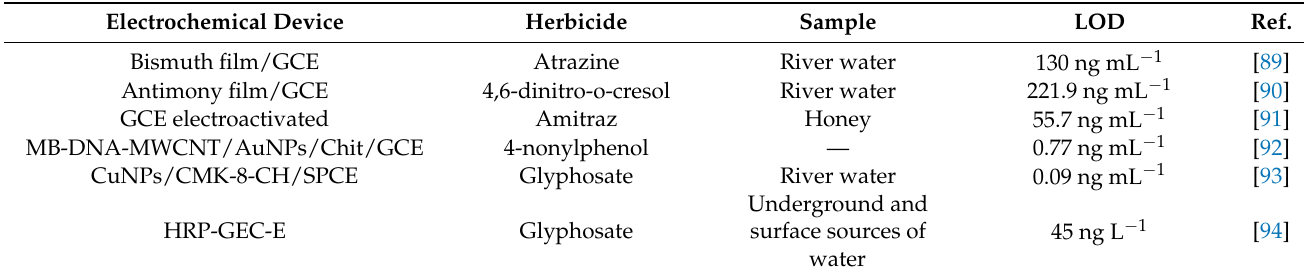
Table 6. Electrochemical sensors/biosensors for herbicides detection developed in Argentina in the last 10 years. See the abbreviation list at the end of the